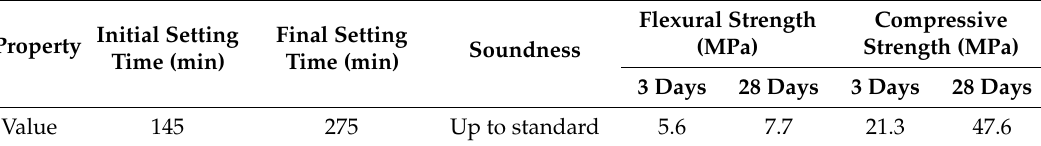
Table 3. Properties of the cement.